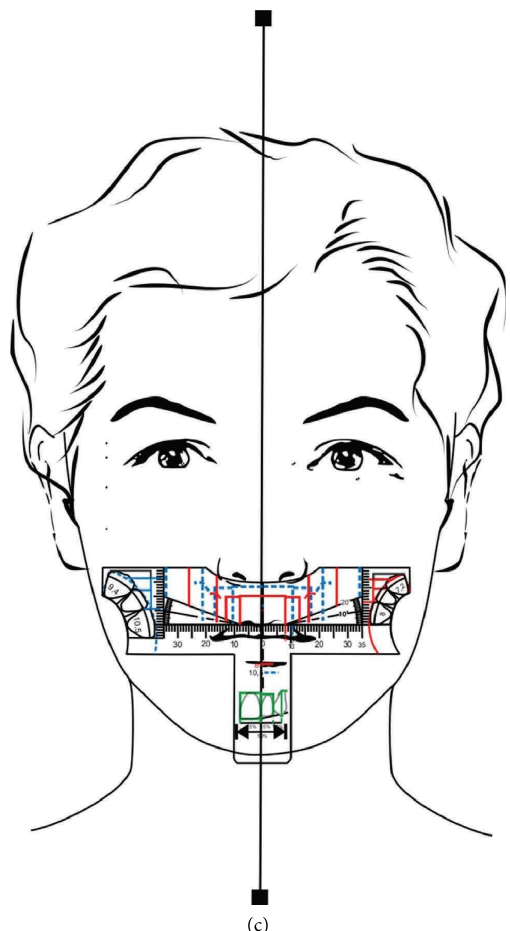
Figure 9: In (a) manual handling of the invention; and in (b) and (c)–illustration of the invention uses in order to choose the ideal option using as parameters intercantal and interalar distances, being the patient’s face serious and at